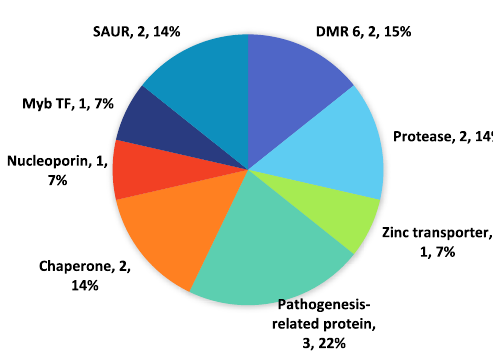
Fig. 5. Classification of defence related genes in qBFR4 according to functional groups